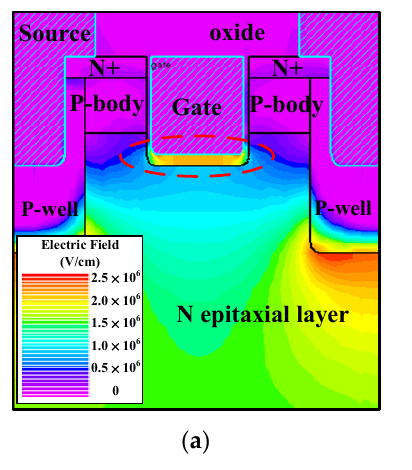
Figure 10. Physical characteristics of the double-trench SiC MOSFET under the avalanche state. ( a ) Distribution of the electric field. ( b ) Extracted E ox and I.I. along the gate oxide